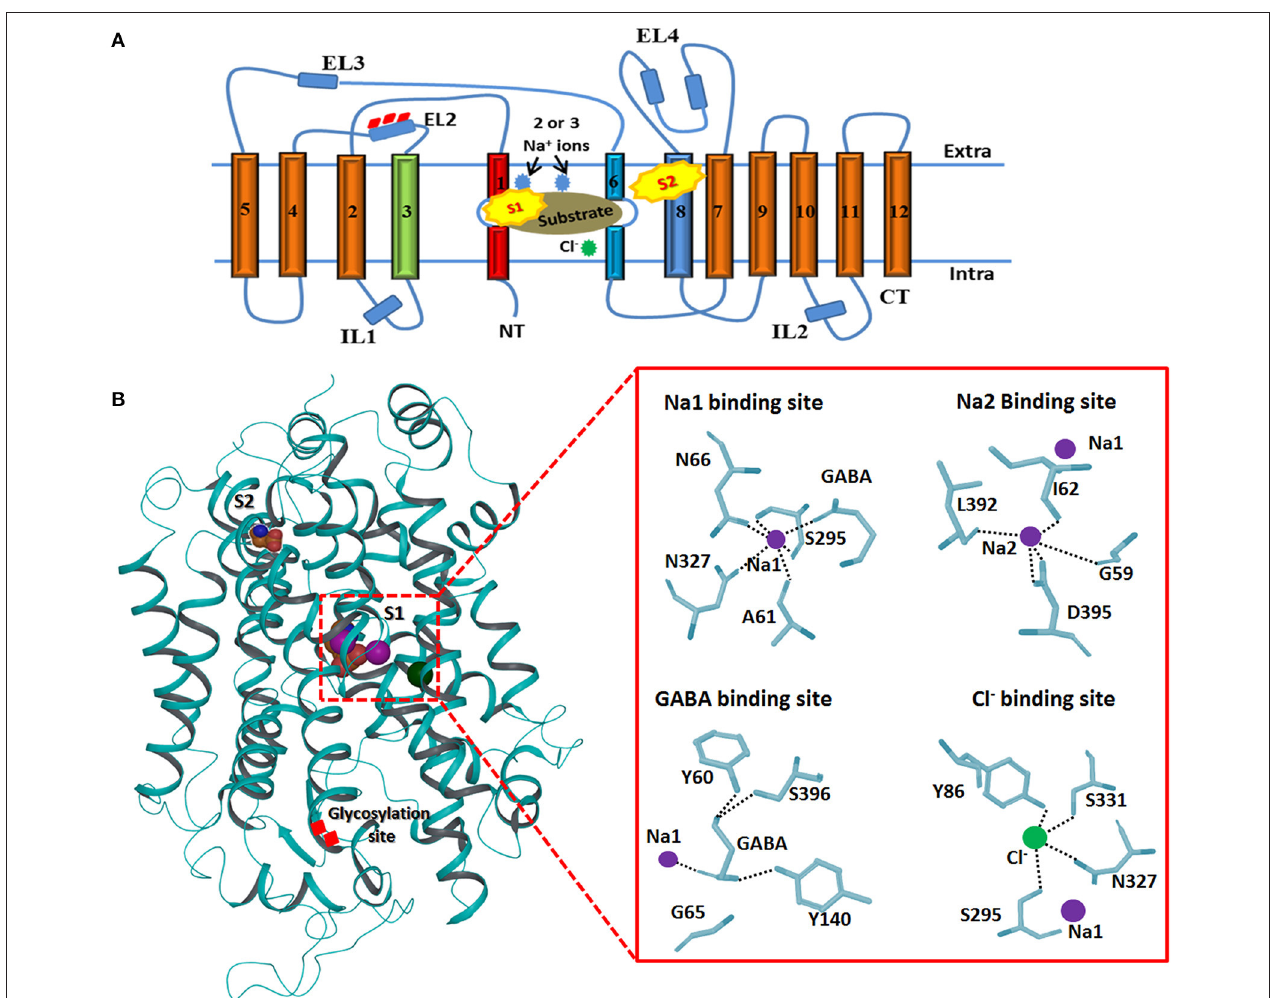
FIGURE 3 | Generalized membrane topology of GATs. (A) The TM segments 1 and 6 (shown in red and light blue) along with the TM segments 3 and 8 (shown in green and dark blue) are involve in the formation of cylindrical ring for binding of the substrate and co-transported ions. Rests of the TM segments are shown in brown. Interconnecting intra- and extracellular loops (ILs and ELs) are represented with dark blue color. S1 and S2 represent the primary and preliminary binding sites of the substrate. (B) 3D structure of hGAT1 possessing substrate (S1 and S2), ions binding sites and glycosylation sites. Purple sphere shows sodium ions and Cl − ion is represented with green color. An enlarge view of GAT1 residues interaction profile of GABA and all three ions is presented on right